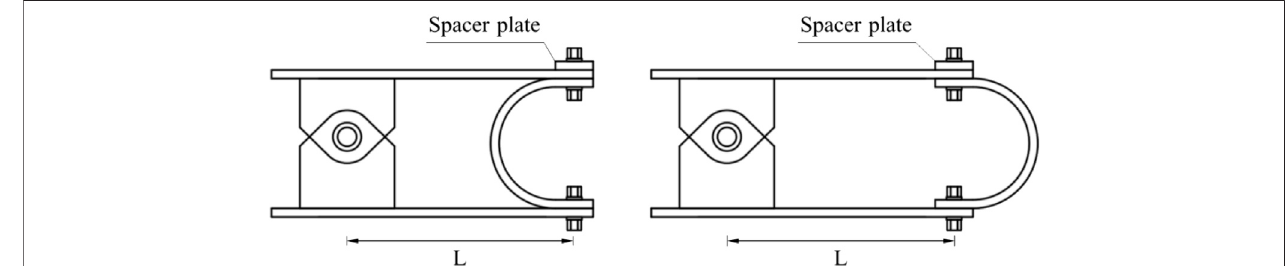
FIGURE 5 | Specimen structure.